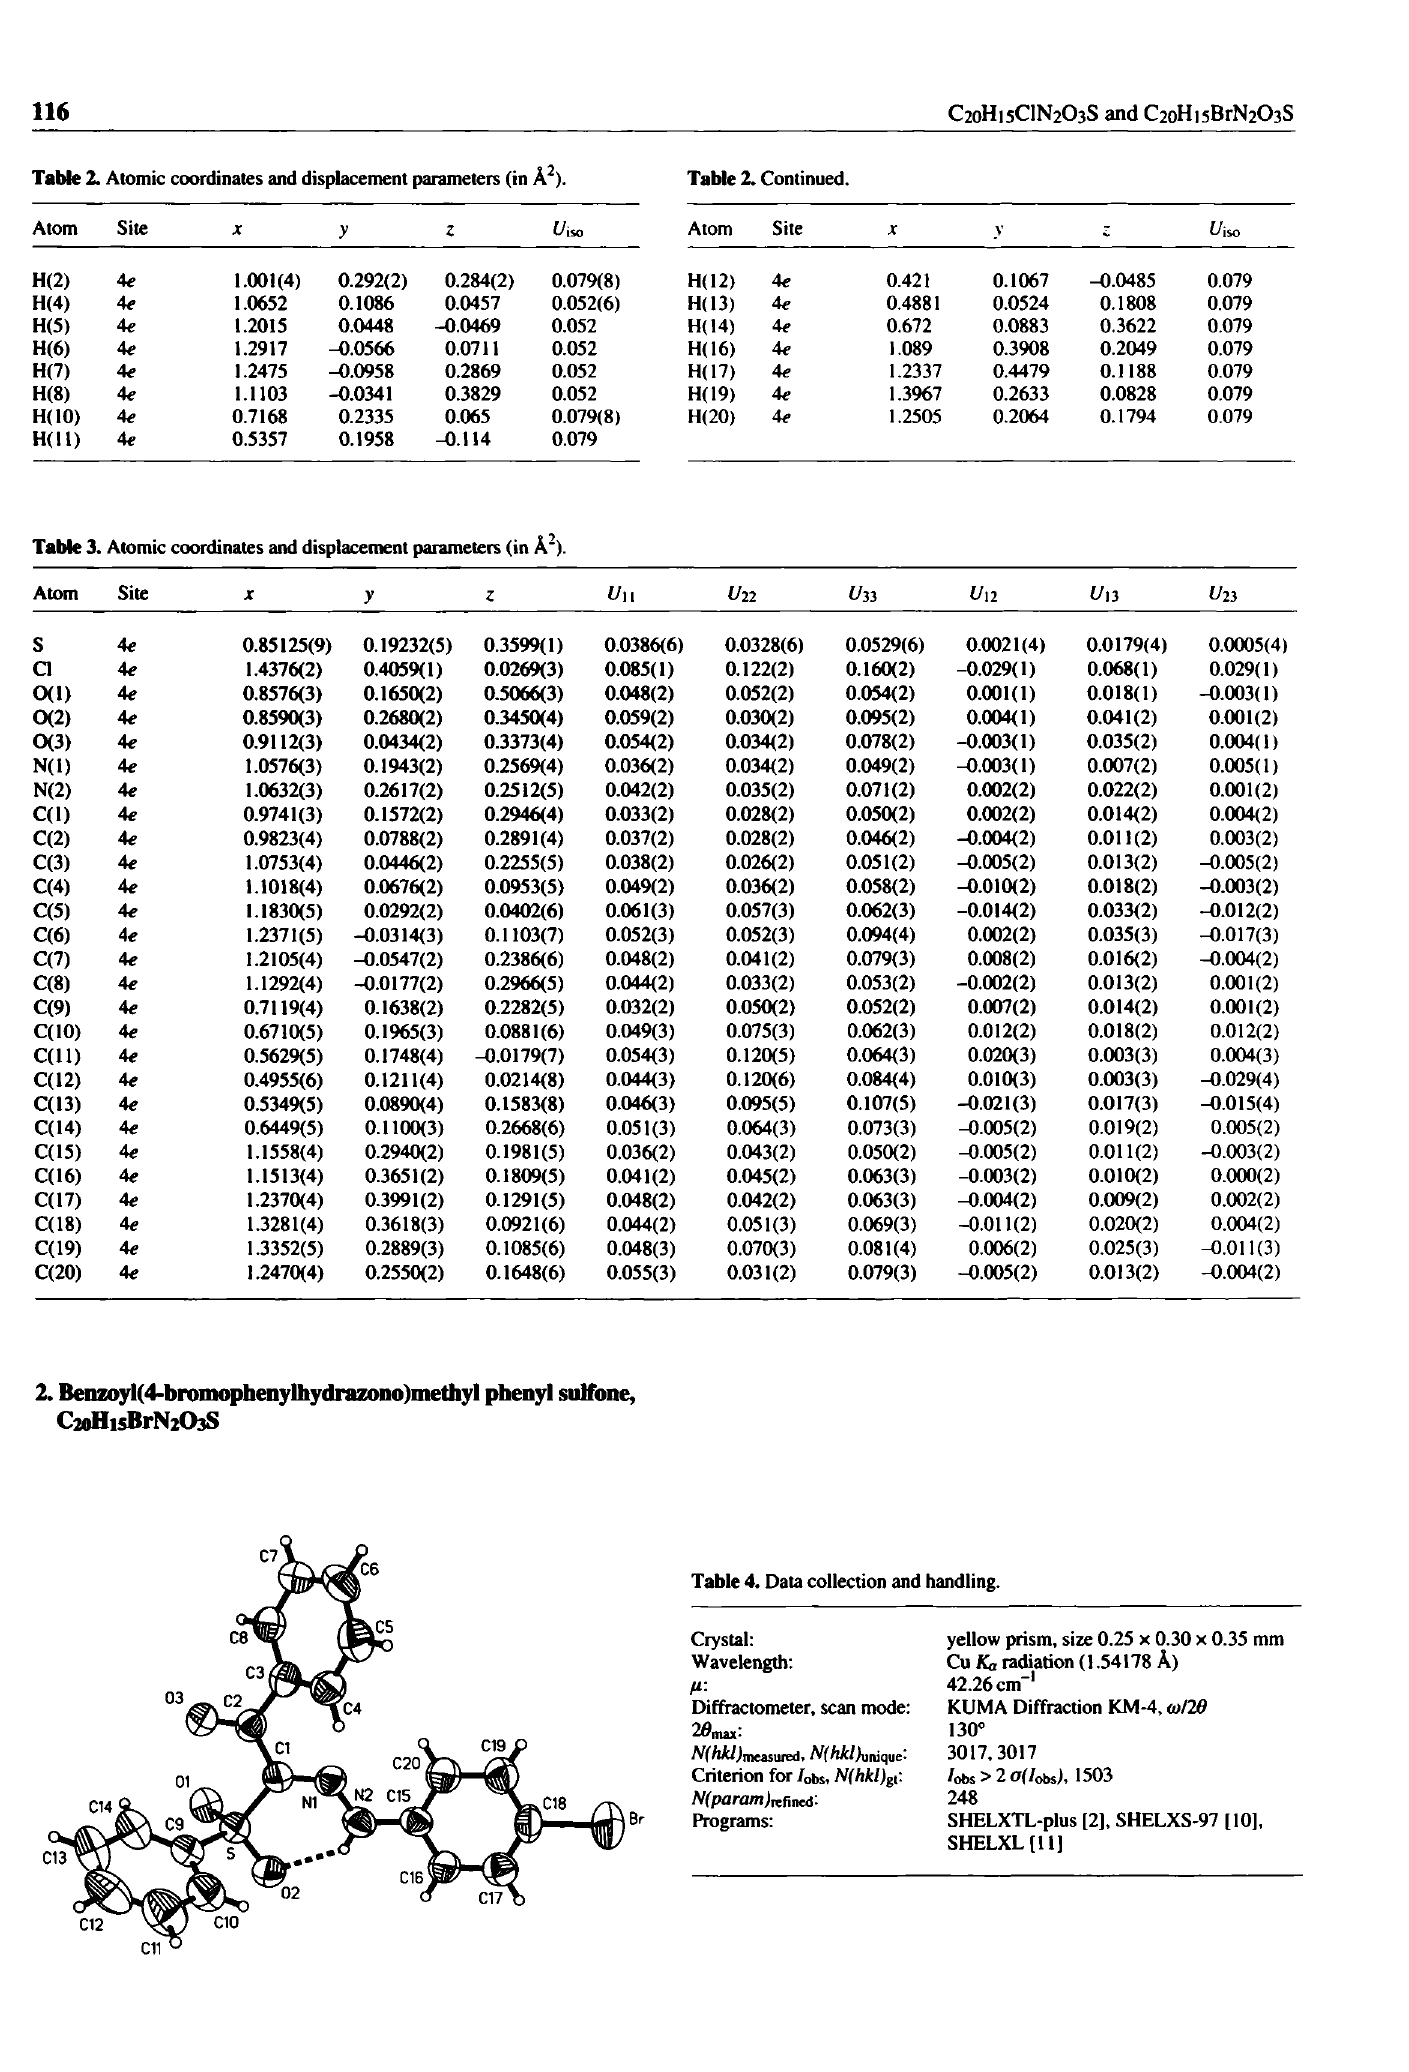
Table 4. Data collection and handling.